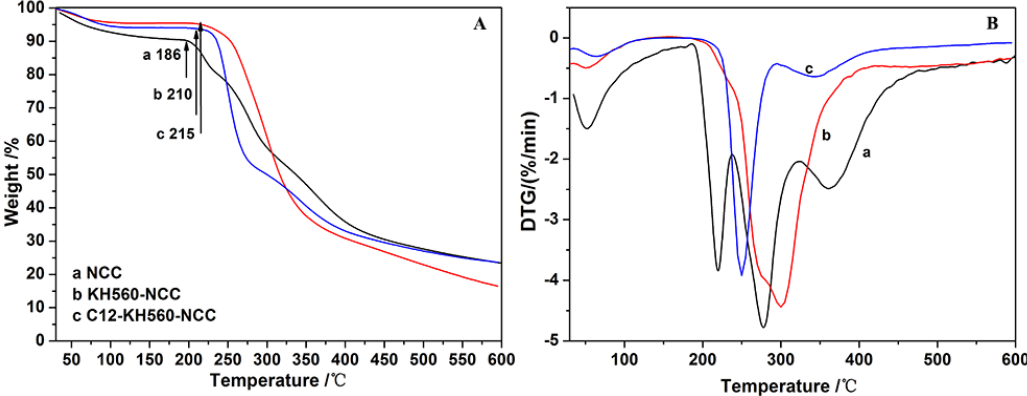
Figure 9. TG curves ( A ) and DTG curves ( B ) of NCC ( a ), KH560-NCC ( b ) and C12-KH560-NCC ( c ). Table 3. Degradation data obtained from TGA for NCC, KH560-NCC and C12-KH560-NCC: T onset and T max corresponds to the beginning of the degradation process and the thermal decomposition temperature associated with the maximum derived signal, respectively.